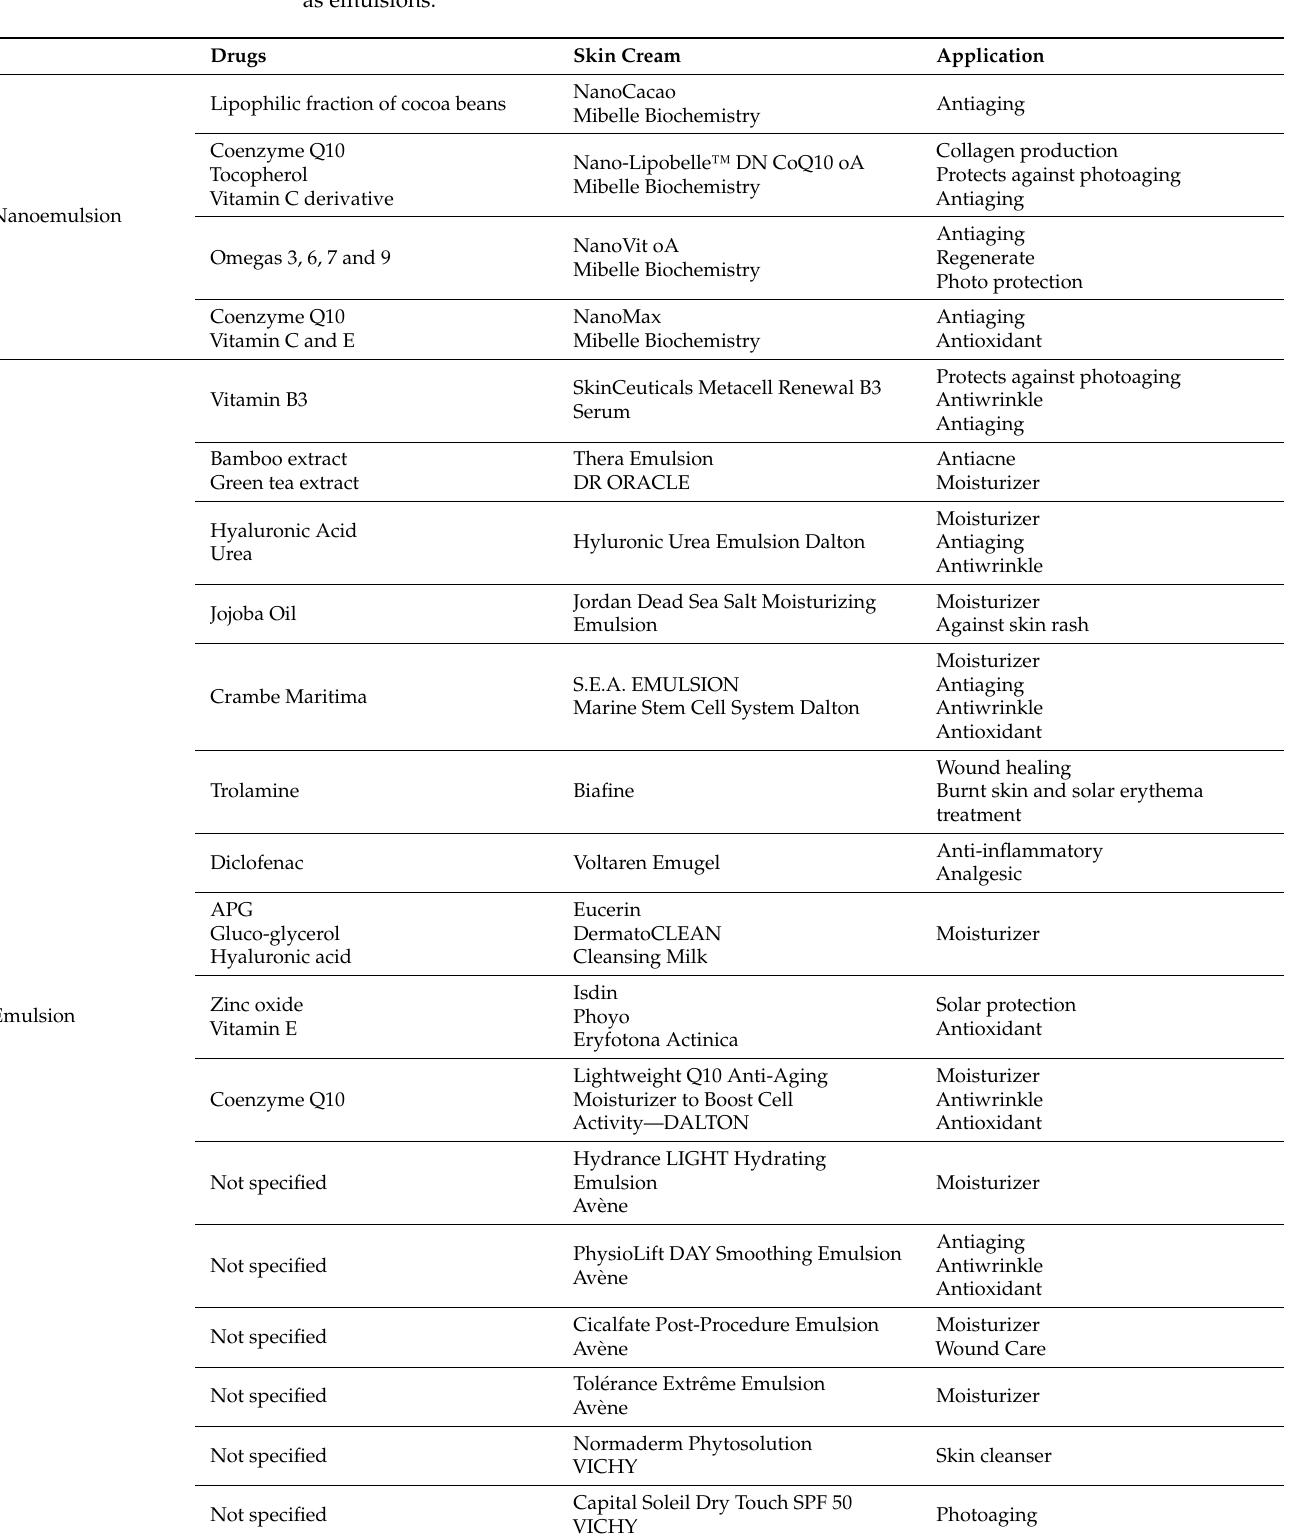
Table 2. Examples of pharmaceutic and cosmetic products, available on the market, formulated as